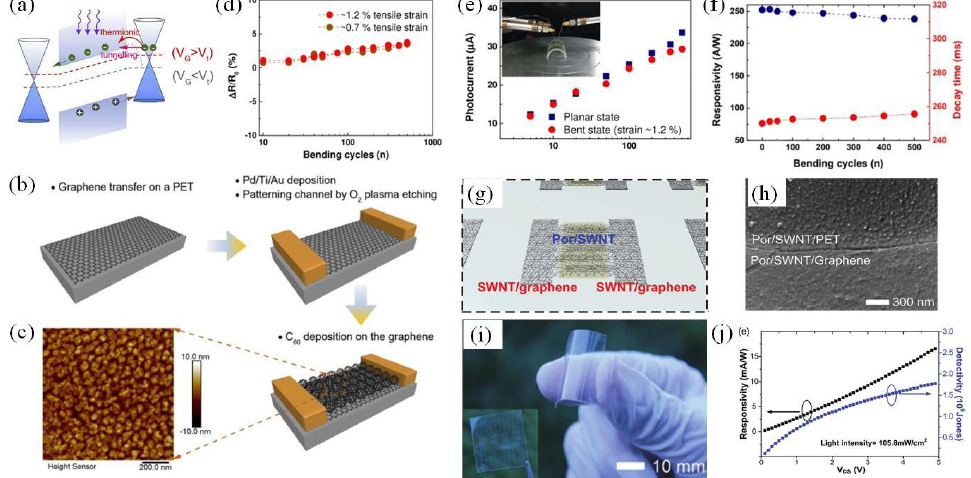
Figure 2. ( a ) Schematic of gate-tunable energy band diagrams of graphene − C 60 − graphene PD under illumination. Reproduced with permission [69]. Copyright © 2022 Elsevier Ltd. All rights reserved. ( b ) Schematic diagram of the manufacturing of graphene-C 60 devices on plastic PET substrates. ( c ) Atomic force microscopy image of C 60 on graphene film. ( d ) Relative change in resistance